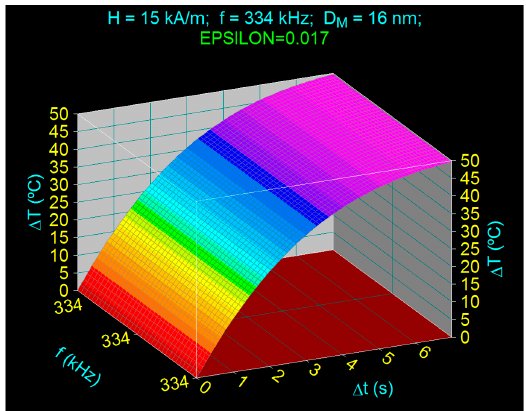
Figure 8. The time variation of the heating temperature of the magnetic nanoparticles in the optimal conditions (when the diameter of the nanoparticles is 16 nm, the magnetic field is 15 kA/m and the frequency of AMF in the admissible biological limit is 334 kHz).